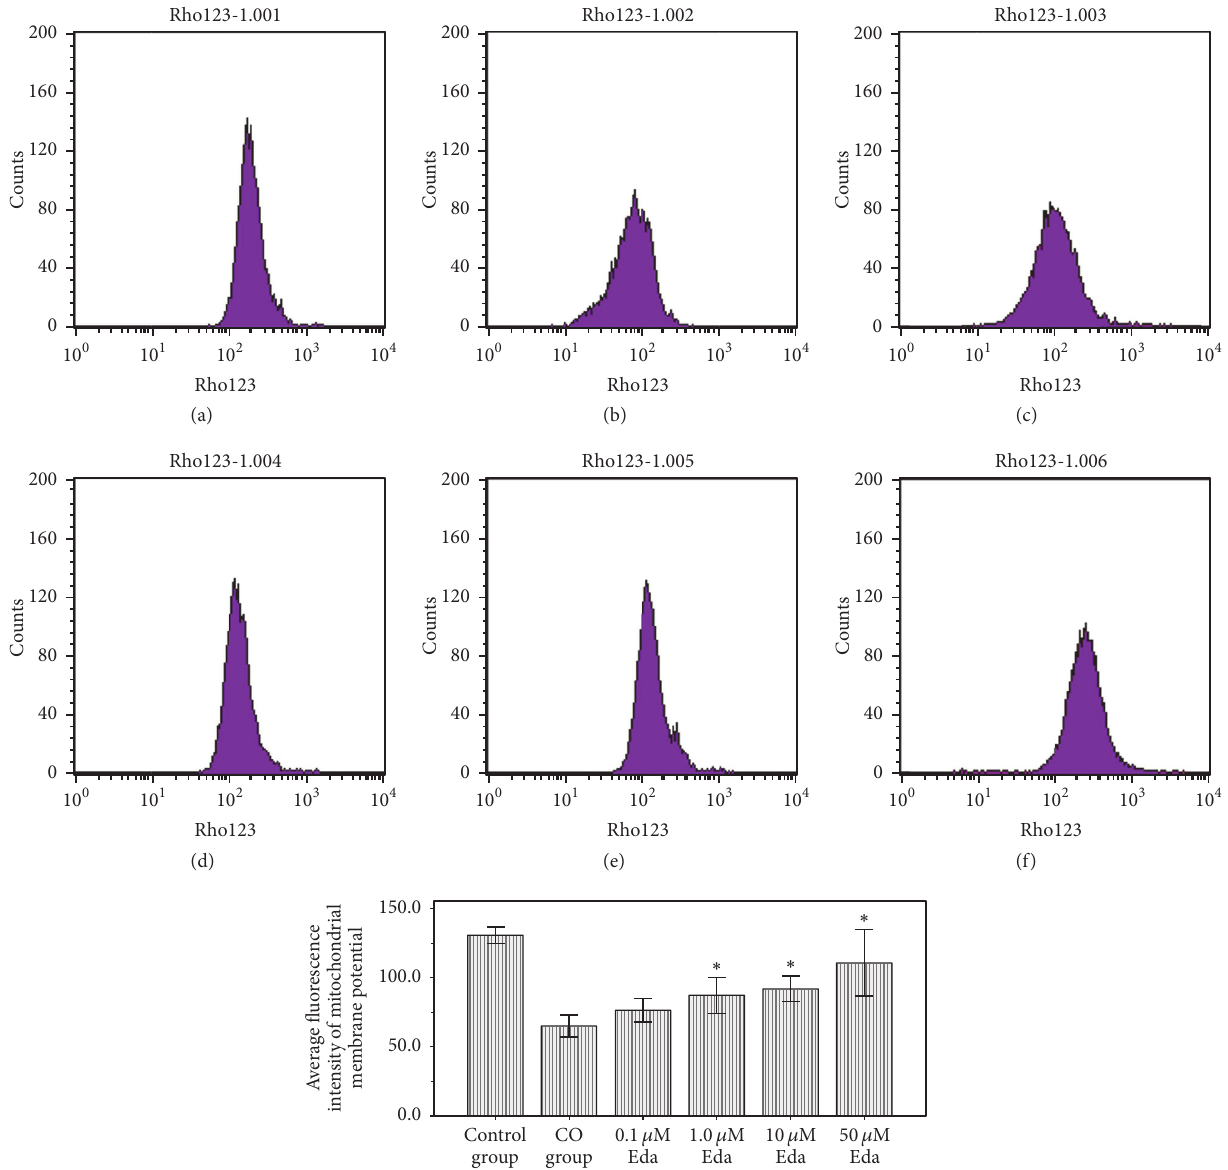
Figure 3: The results of mitochondrial membrane functional measurement. Mitochondrial membrane potential of each group was measured using FCM with Rhodamine 123 staining. (a) Control group, (b) CO group, (c) 0.1 𝜇 M Eda group, (d) 1.0 𝜇 M Eda group, (e) 10 𝜇 M Eda group, and (f) 50 𝜇 M Eda group. Compared with CO group: ∗ 𝑃 < 0.01 . Three biological replicates were prepared for each sample in this